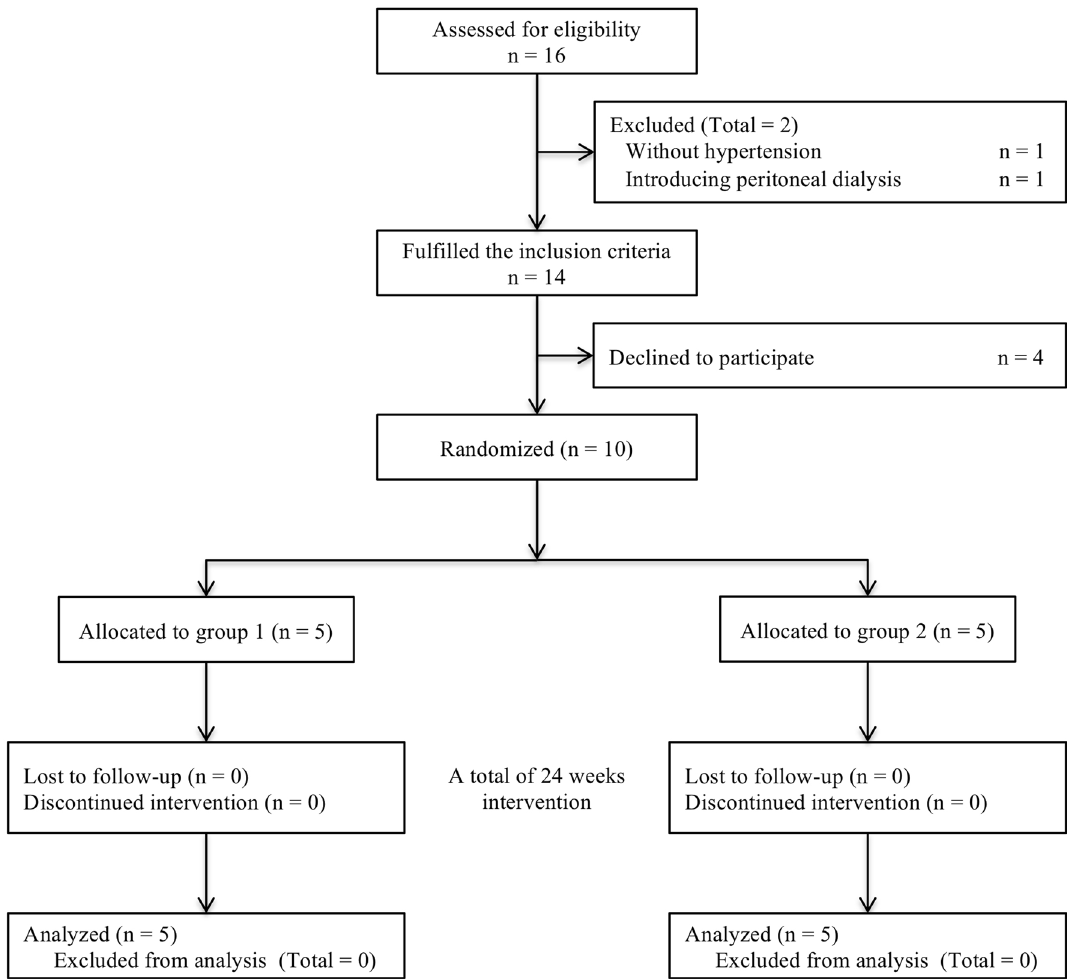
Figure 1. CONSORT flow diagram of patients through the various phases of the trial